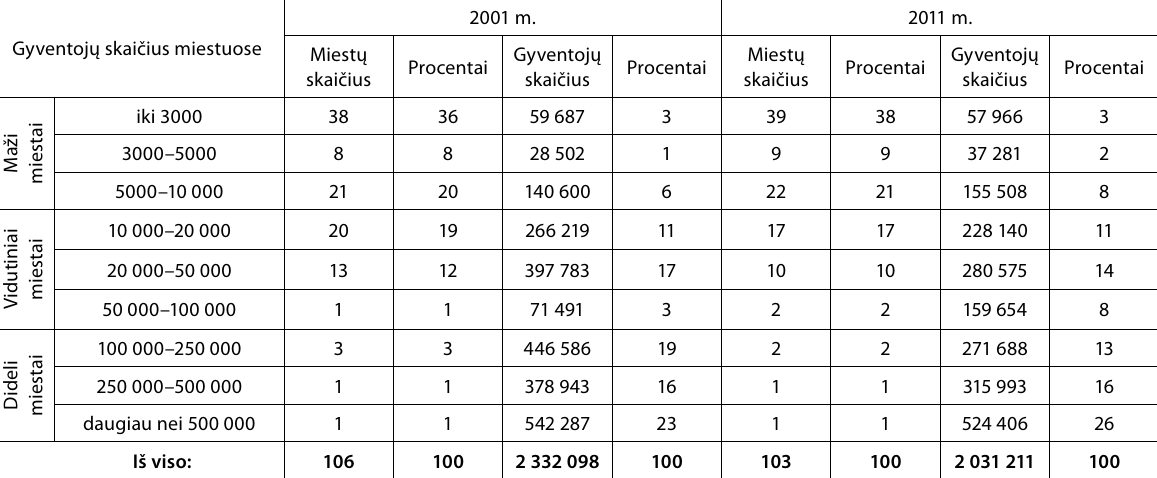
Table 4. The number of towns according population 2001–2011 (according analysis of lithuania statistics department results of Census of population and housing in 2001–2011 of the republic of lithuania) 2001 m. 2011 Gyventojų skaičius miestuose